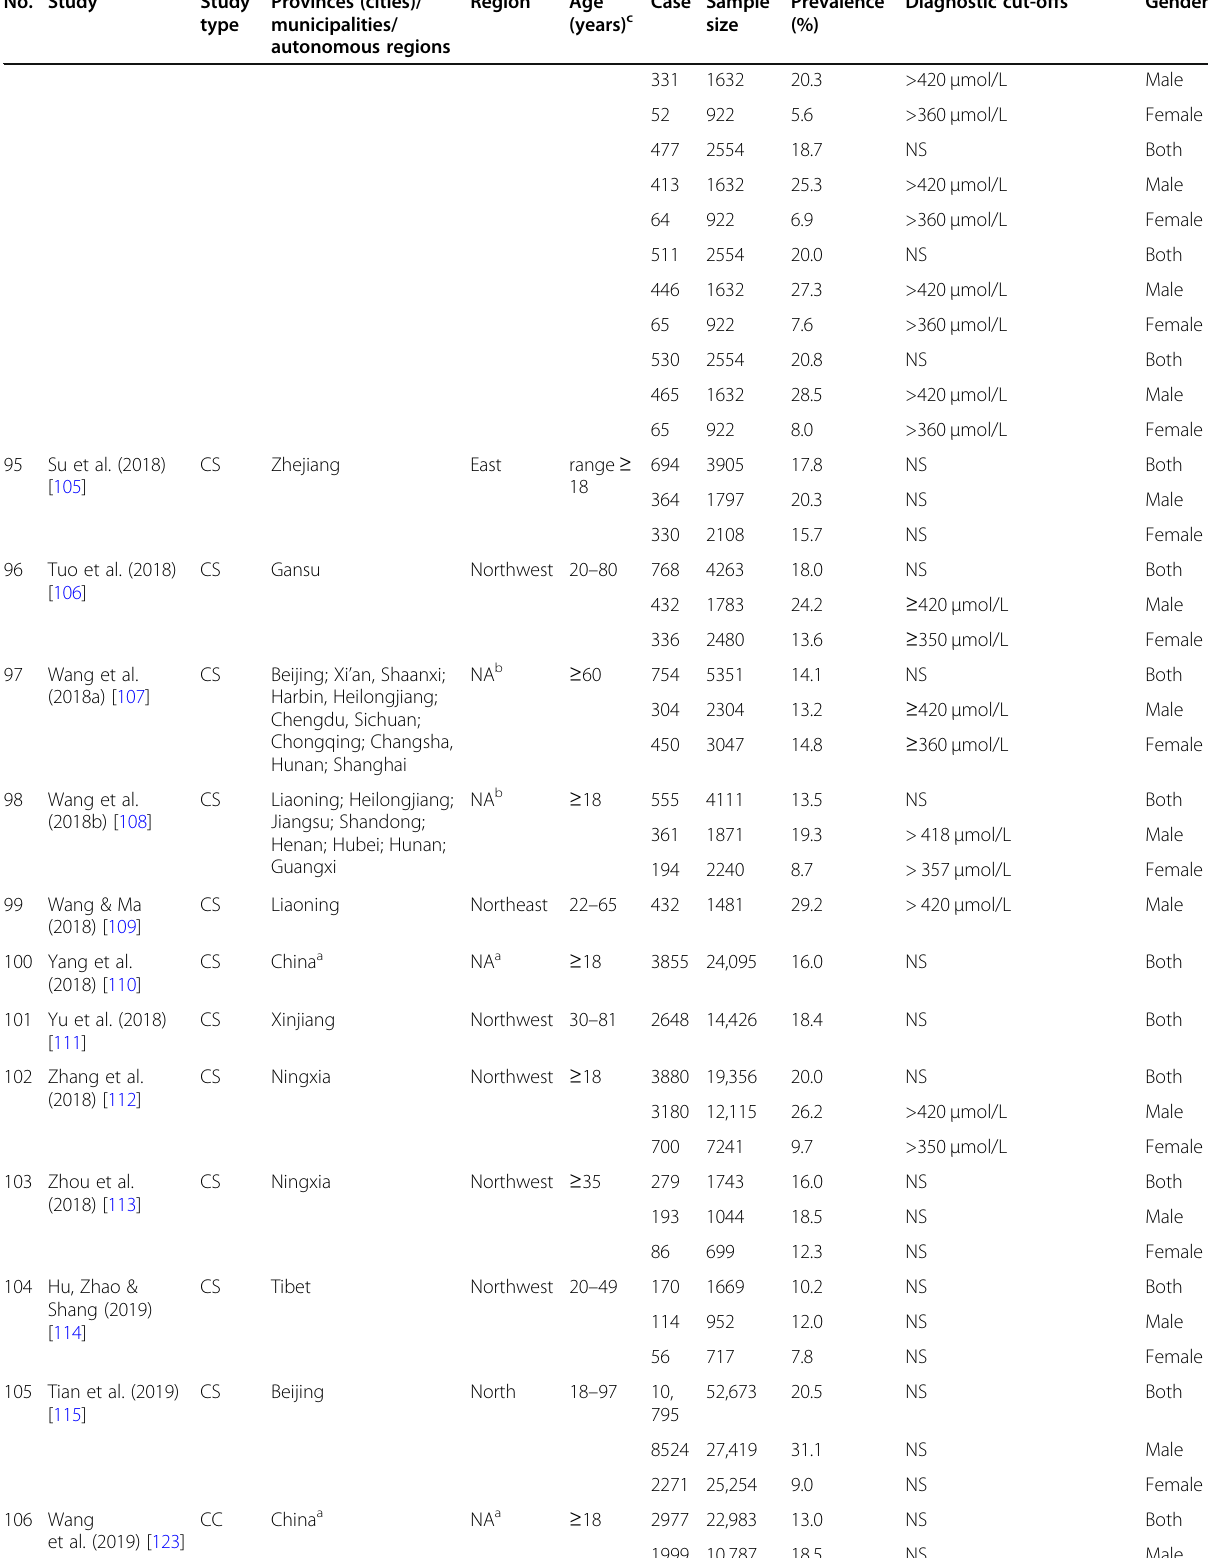
Table 1 Characteristics of the included studies in the systematic review and meta-analysis (Continued) No.